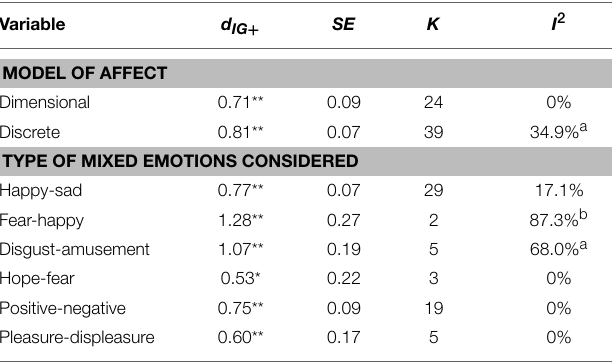
TABLE 2 | Average effect sizes across models of affect and across different types of mixed emotions. Variable d IG